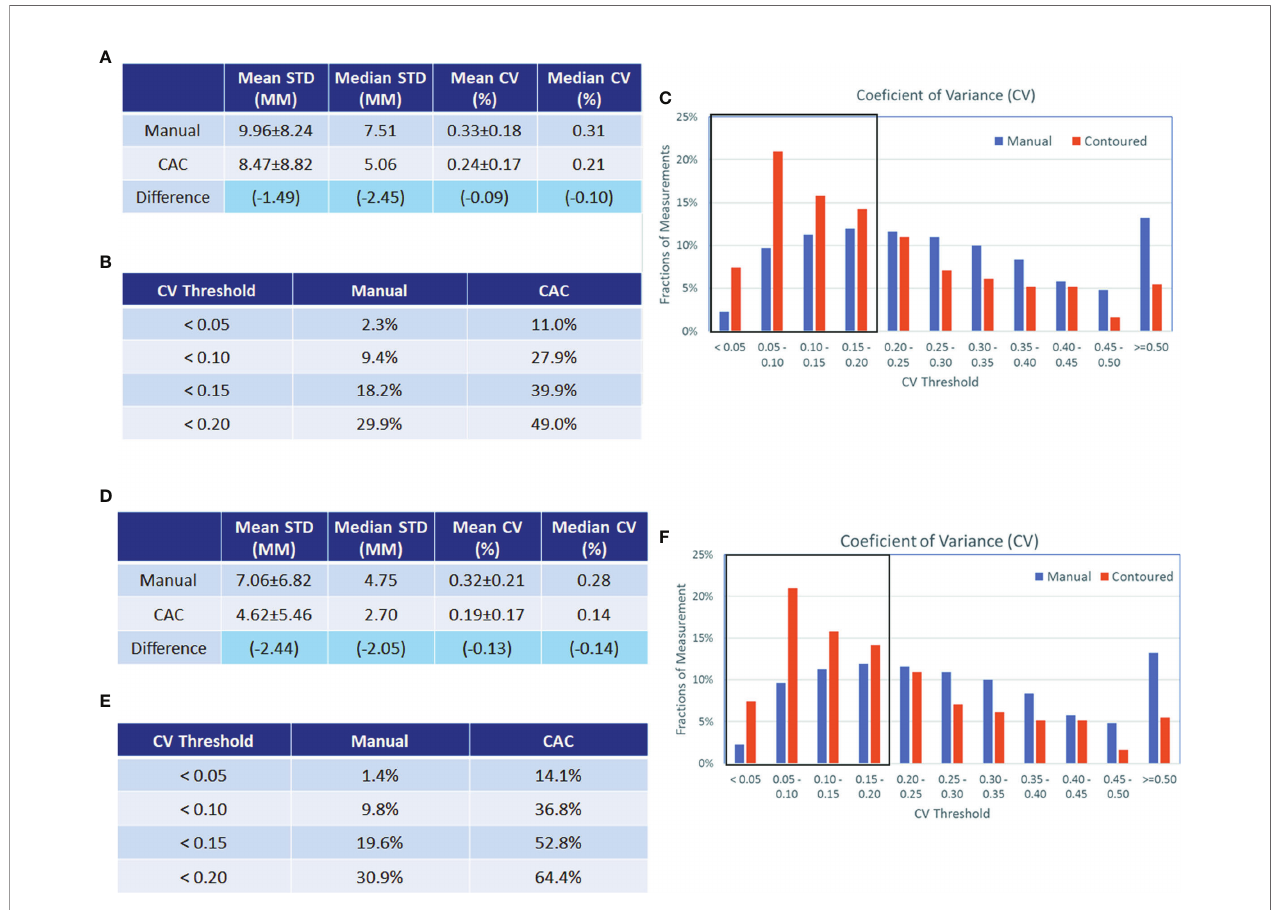
FIGURE 8 | Analysis of coef fi cients of variance (CV) in the experiential learning and testing study. Analysis of coef fi cients of variance (CV) in the experiential learning study (data set 1, A – C ) and in the testing set (data set 2 D – F ). The standard deviation (STD) and CV of the manual and CAC measurements (mean and median values given in a and d, respectively) and the CV distribution ( B , E , respectively) are shown before and after learning. The boxplots in (C, F) show the fractions of measurements with good agreement (<0.2). In data set 1, this was 29.9% vs. 49.0% for manual and CAC measurement, respectively, and in data set 2, this was 30.9% vs. 64.4% for manual and CAC measurements,